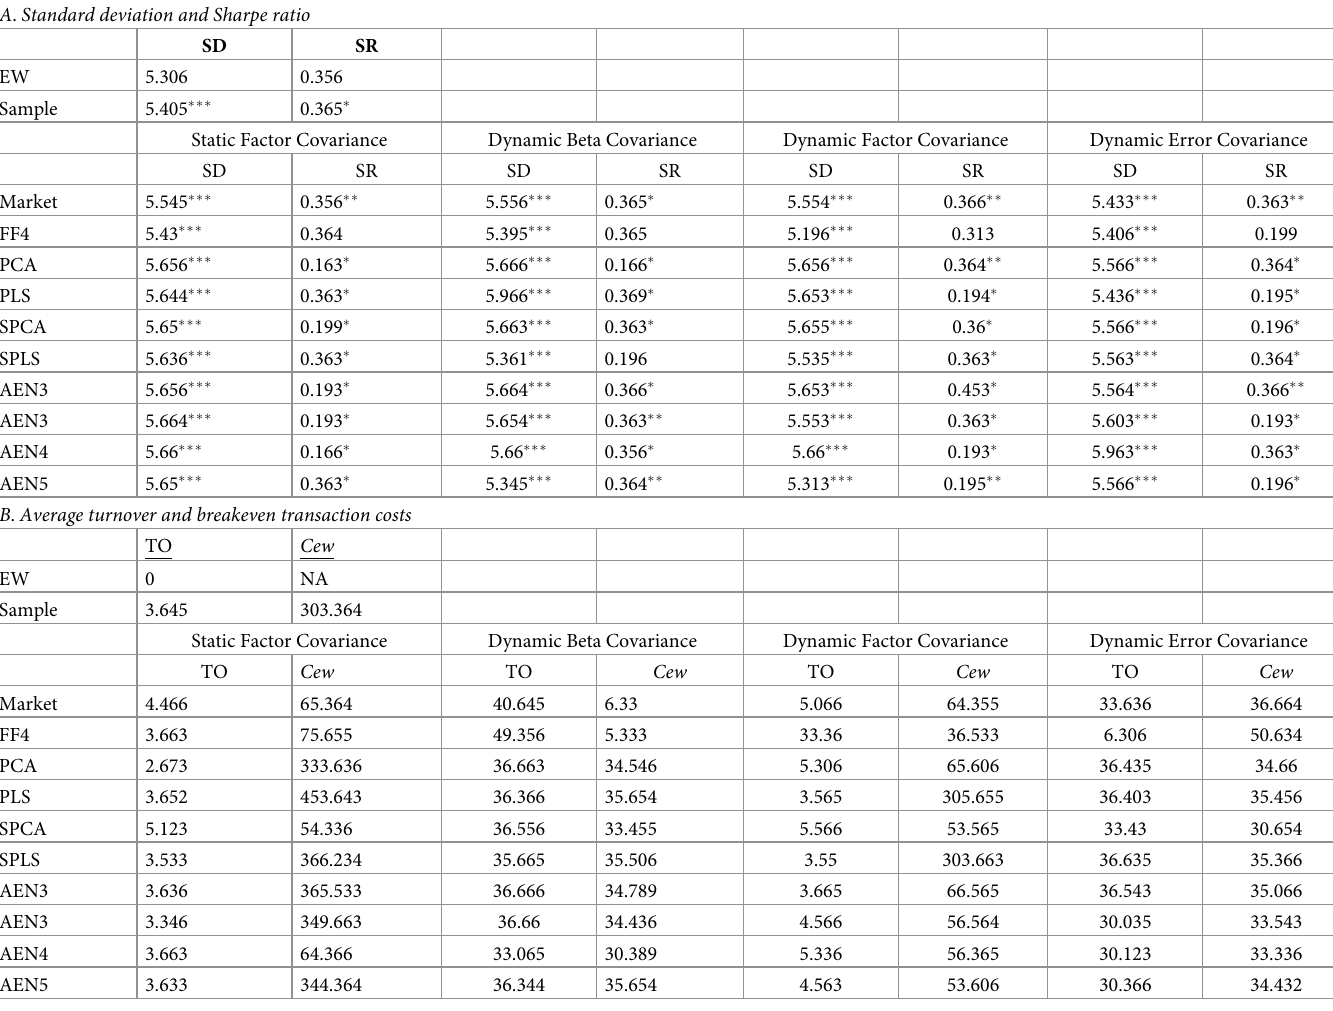
Table 8. S&P 500 and 20-(Fama and French)-portfolios performance depending on size and book-to-market. A . Standard deviation and Sharpe